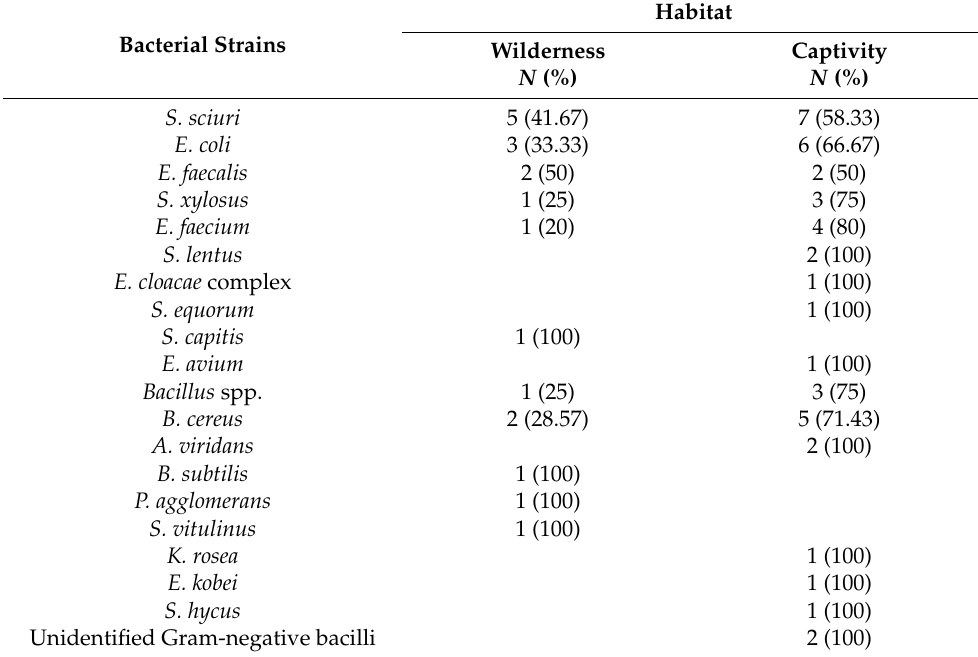
Bacterial Strains